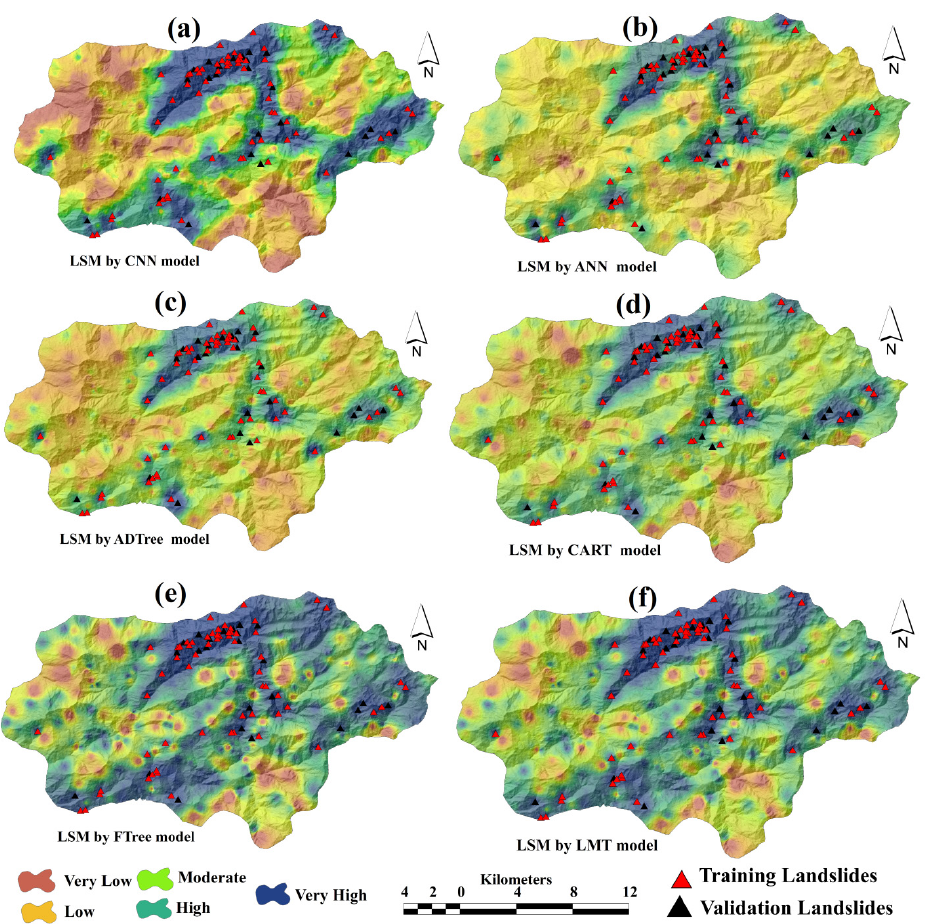
Figure 8. LSMs produced by the ML models: ( a ) CNN, ( b ) ANN, ( c ) ADTree, ( d ) CART, ( e ) FTree and ( f ) LMT.